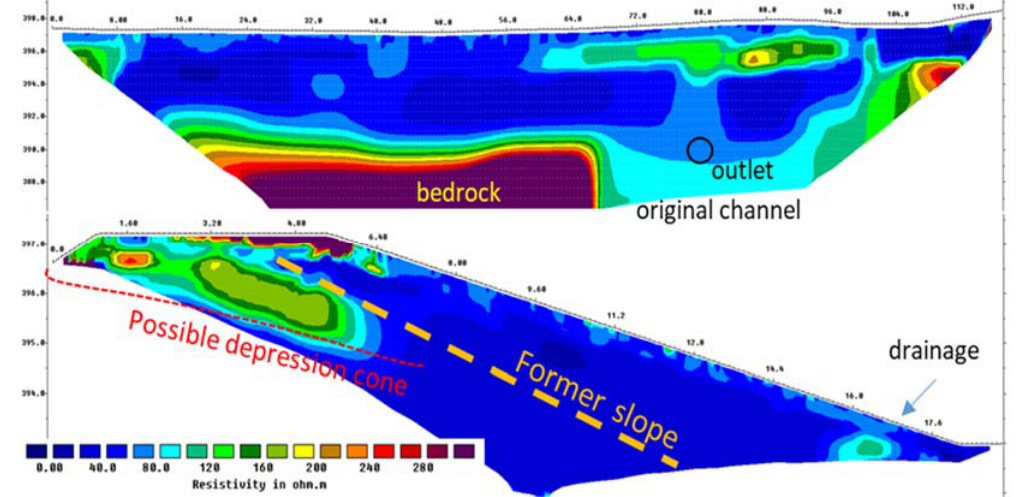
Figure 3. Longitudinal ( top ) and transversal ( bottom ) ERT transects. Blue color represents nearly saturated regions, green to violet are dry areas or bedrock.